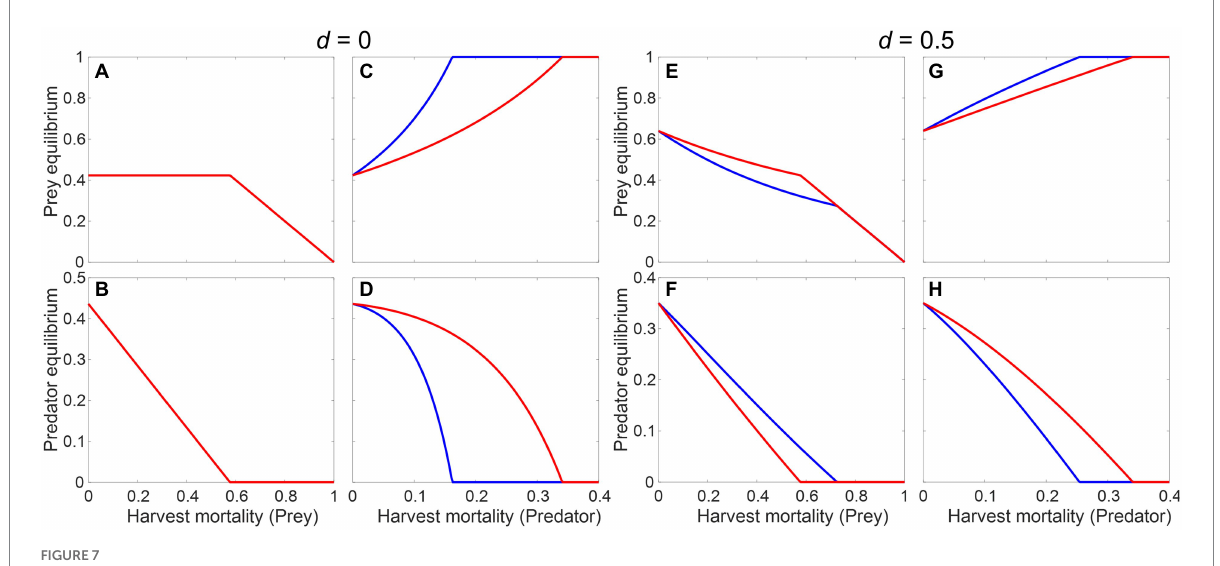
FIGURE 7 Effect of harvest on the equilibrium biomasses of predator and prey, based on the modified Rosenzweig–MacArthur model (Equation 7a and 7b) without (A–D) or with predator’s direct density dependence (E–H) , measured by the parameter d . Red and blue lines represent the system dynamics with and without a metabolic response, respectively. Parameter